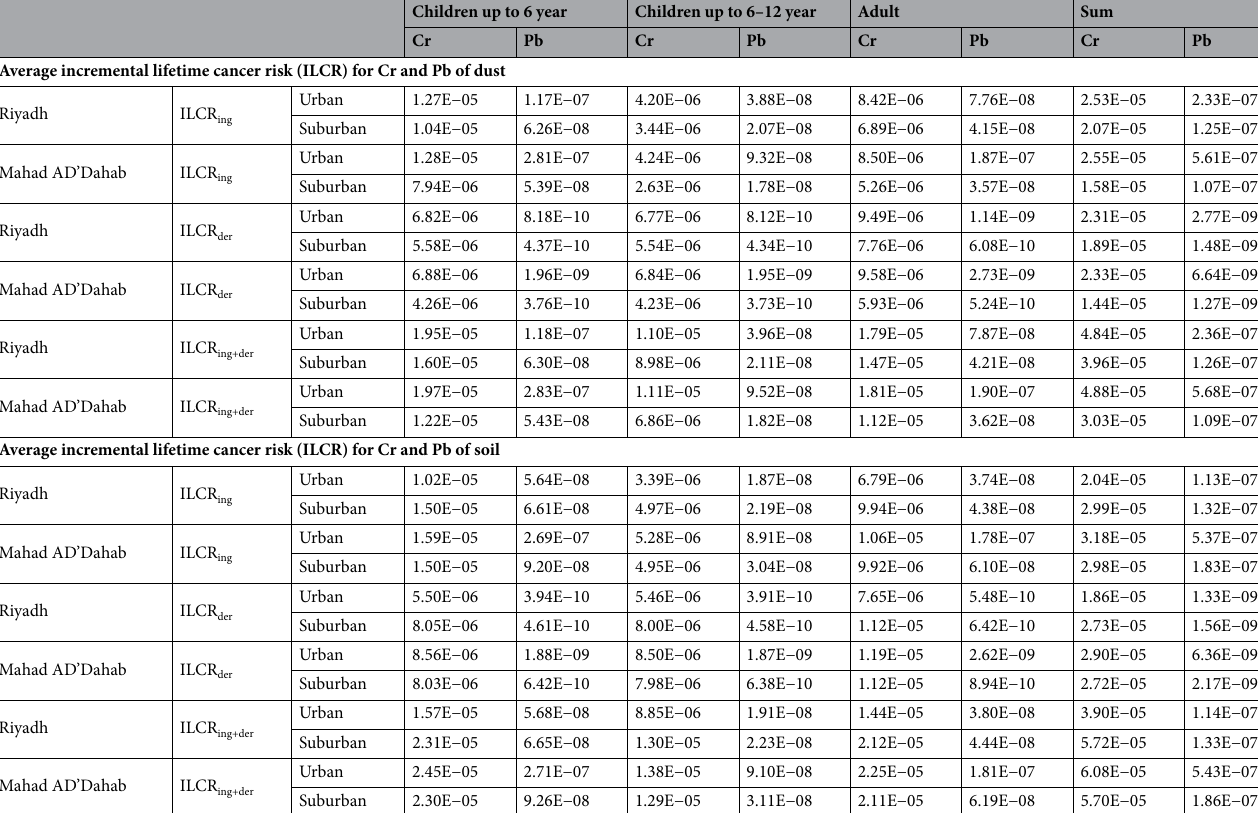
Table 7. Average incremental lifetime cancer risk (ILCR) for Cr and Pb of dust in urban and suburban areas in Riyadh and Mahad